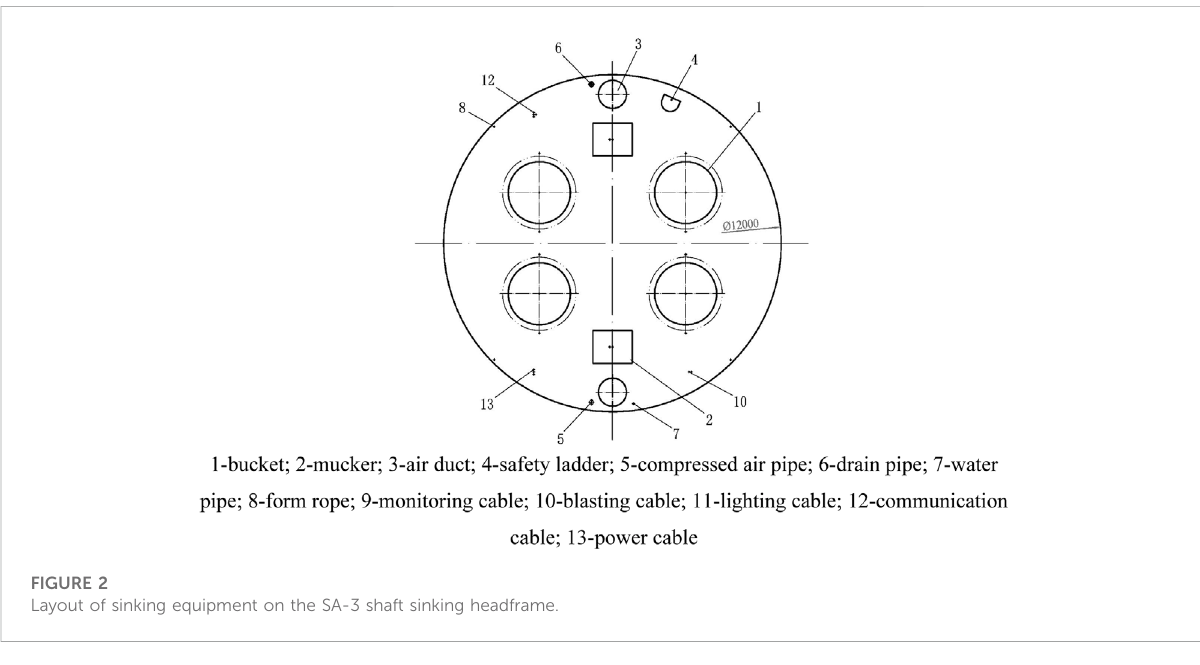
FIGURE 2 Layout of sinking equipment on the SA-3 shaft sinking headframe.